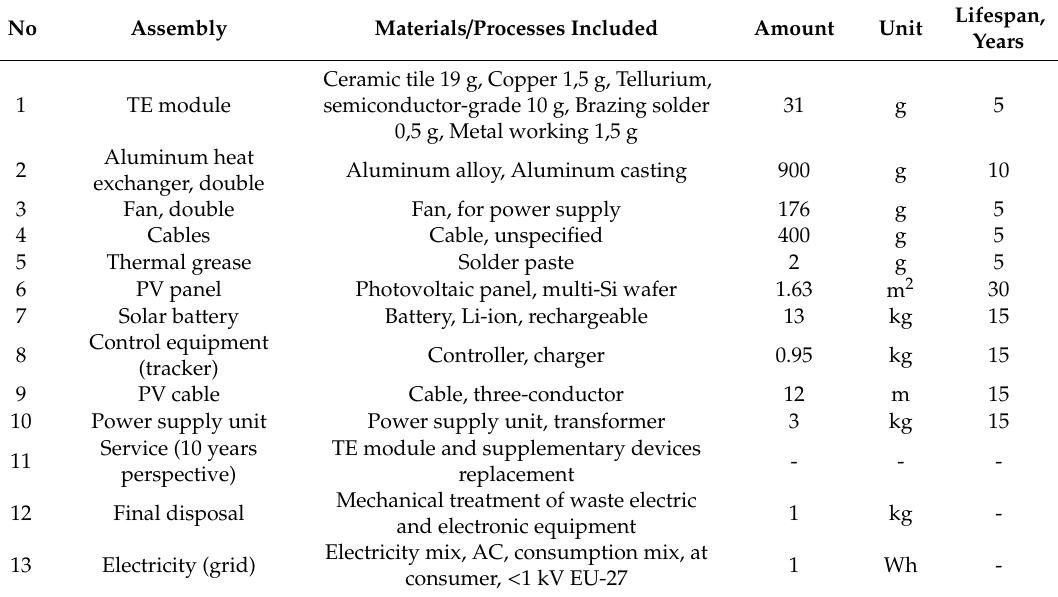
Table A1. Simplified assembly used for assessment of TE cooling system with two supply options (Scenarios 1–3), based on authors’ measurements, calculations, producer data and related processes adopted from [31].